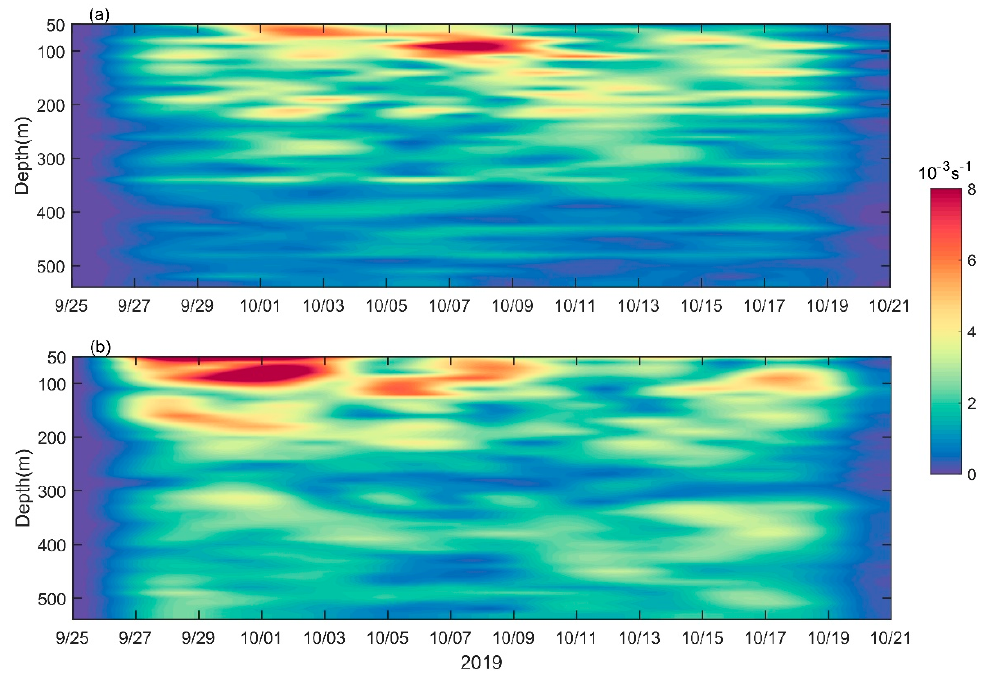
Figure 17. Depth − time maps of the low-pass filtered vertical shear of the ( a ) NIWs and ( b ) M 2 internal tide.